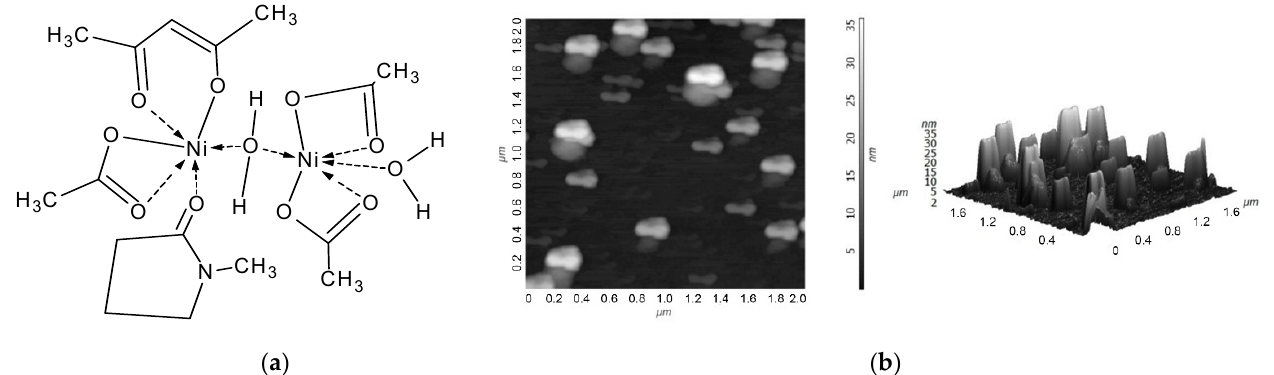
Figure 1. ( a ) Structure of the complex Ni 2 (OAc) 3 (acac)NMP · 2H 2 O (“A”); ( b) the AFM 2D and 3D images of nanoparticles based on Ni 2 (OAc) 3 (acac)NMP · 2H 2 O (2 µ m × 2 µ m).